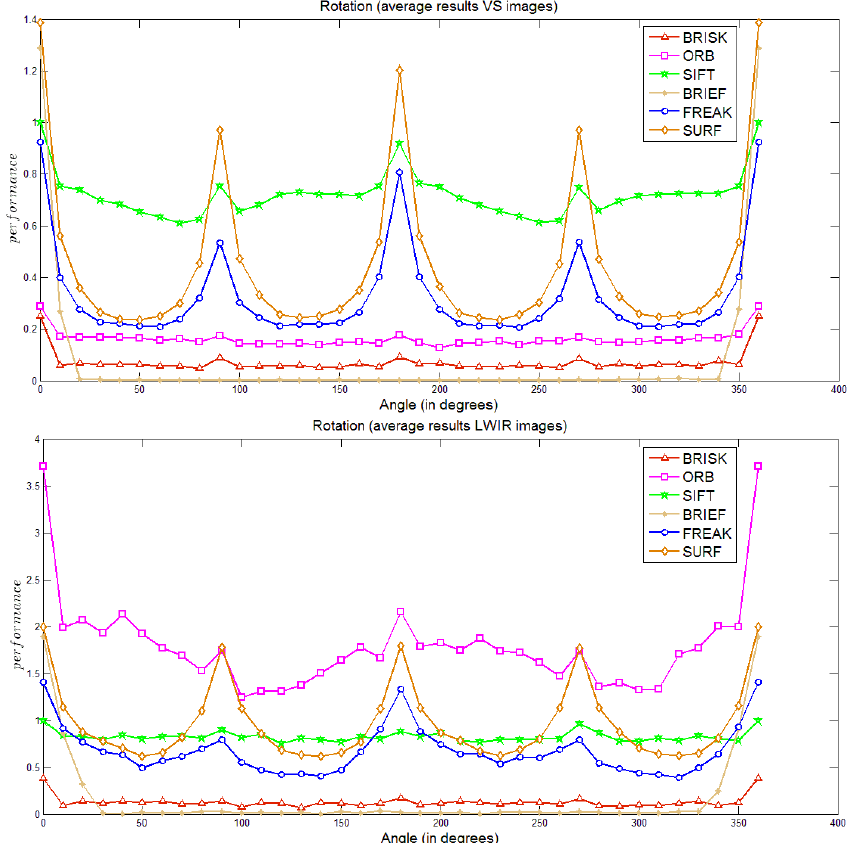
Figure 3. Performance in the rotation case: ( a ) visible spectrum; ( b ) LWIR